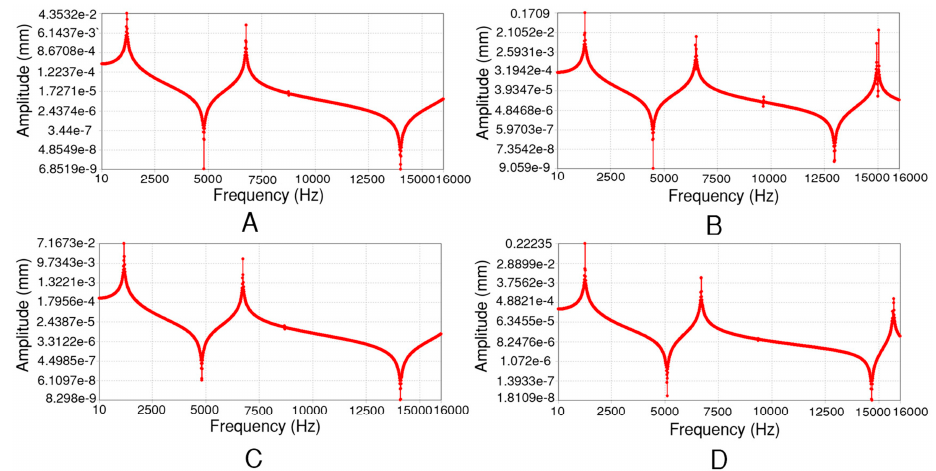
Figure 10. Amplitude response curve of ( A – D )-type end milling cutter in x direction.